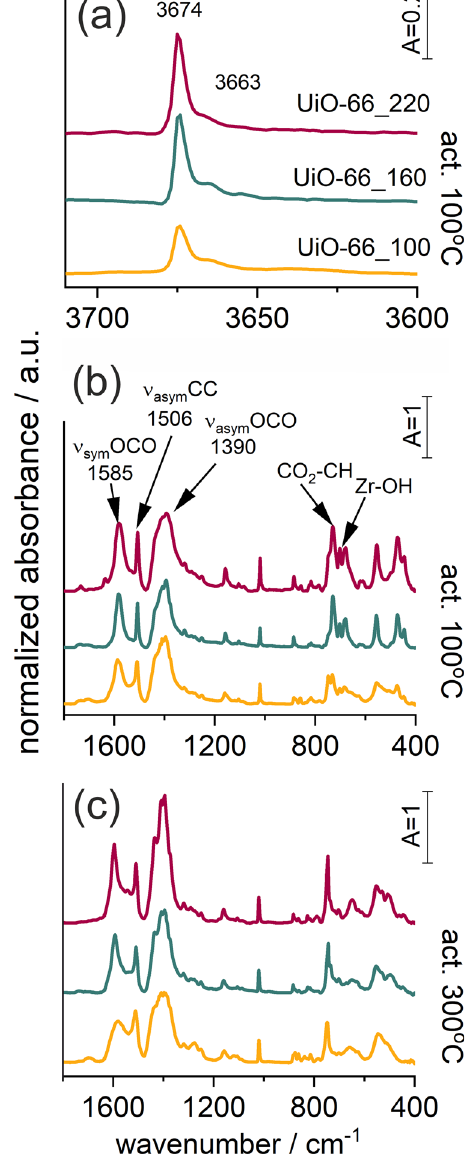
Fig. 6 IR spectra of UiO-66 material. a The range of OH groups, b the range of skeletal vibrations, both for sample activated at 100°C; c the range of skeletal vibrations for sample activated at 300 °C. Normalized to the same band height of 1020 cm − 1